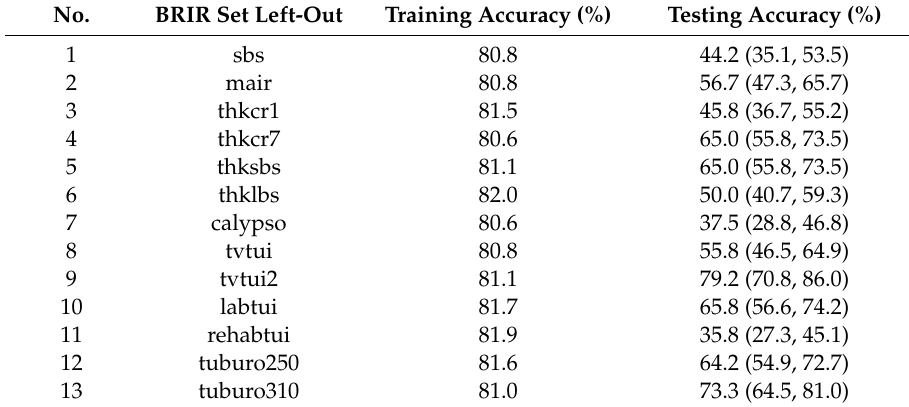
Table 8. The results of the leave-one-BRIR-out validation. Numbers in brackets represent 95% confidence intervals.